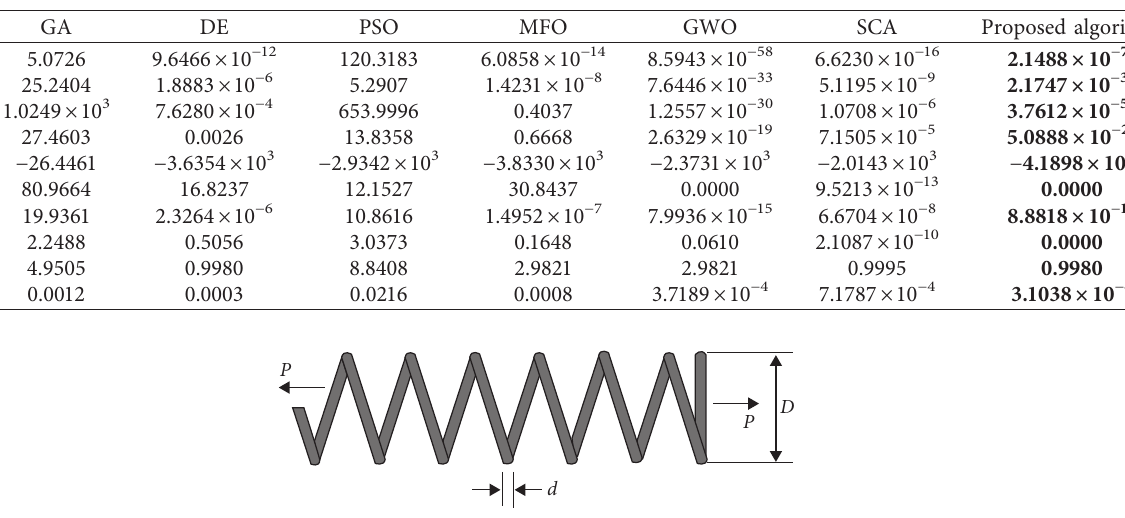
Figure 4: The model of tension/compression spring design